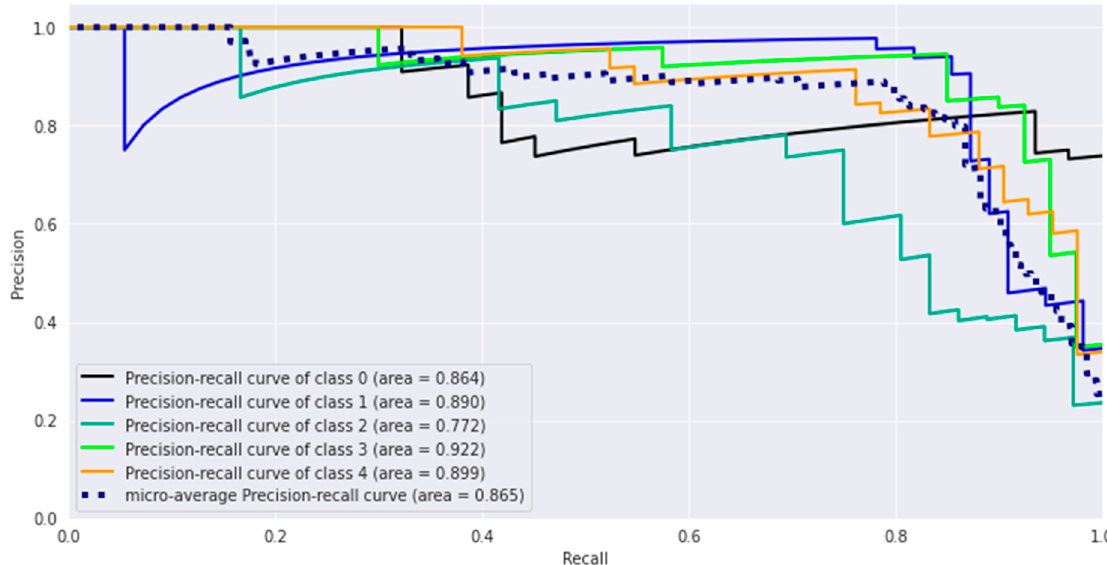
Figure 12. The precision-recall curve of random configuration. Table 4. Classifier’s performance comparison for 3 × 3